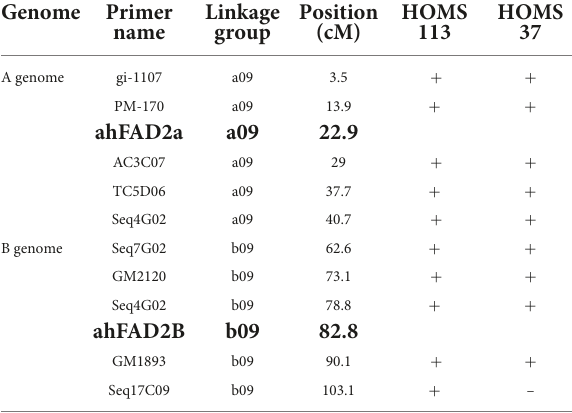
TABLE 8 Details of SSRs used for testing of recombination nearby target loci in selected two high oleic breeding lines. Genome